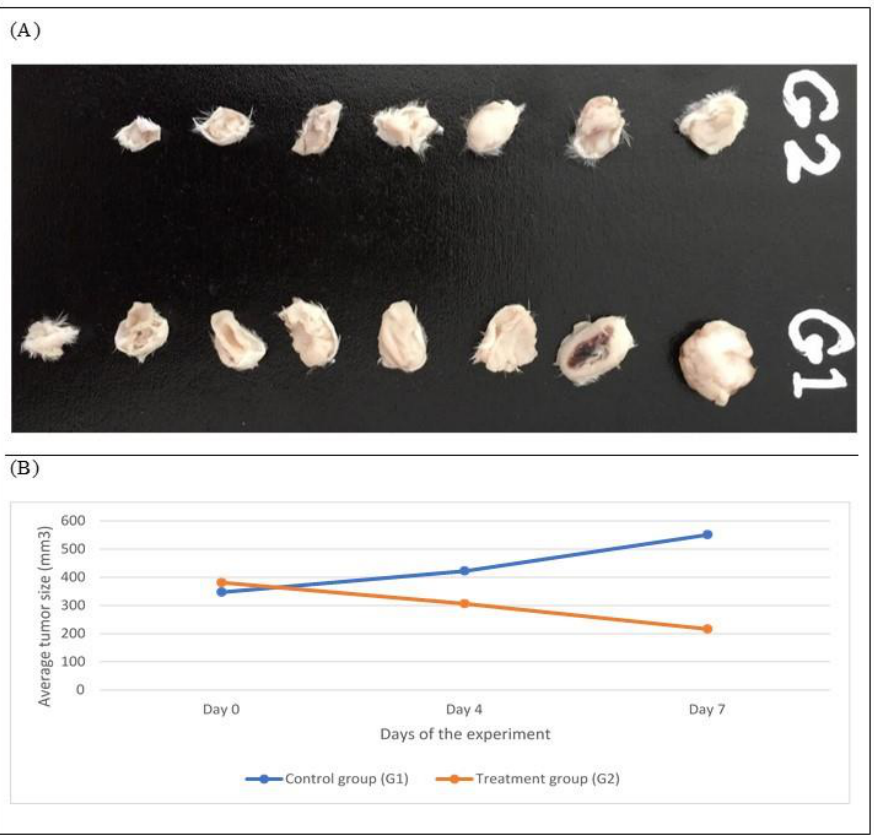
Figure 4. ( A ) Comparison of tumor sizes after dissection at day 7 in all groups, n = 8. G1 = Control, G2 = Treated. ( B ) Treatment progression represented as mice’s average tumor size (mm3) over time.